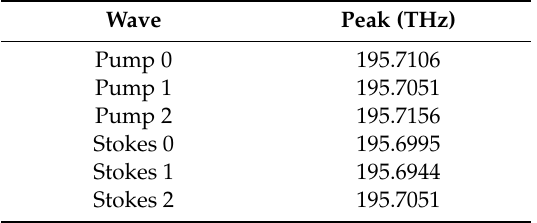
Table 1. The peak frequencies of the different optical waves in the system.